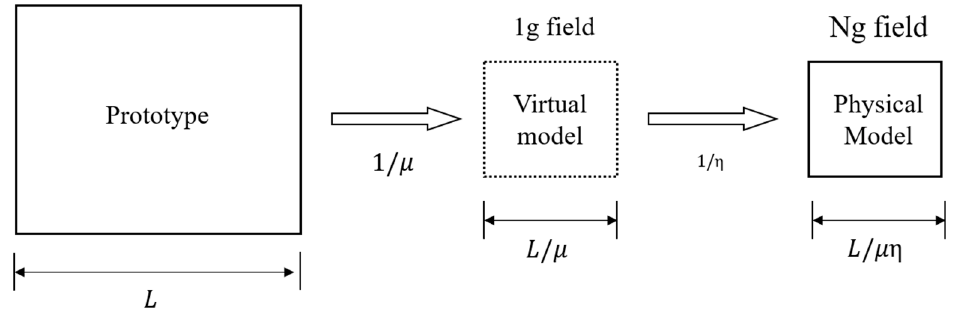
Figure 3. Concept of two-stage scaling.